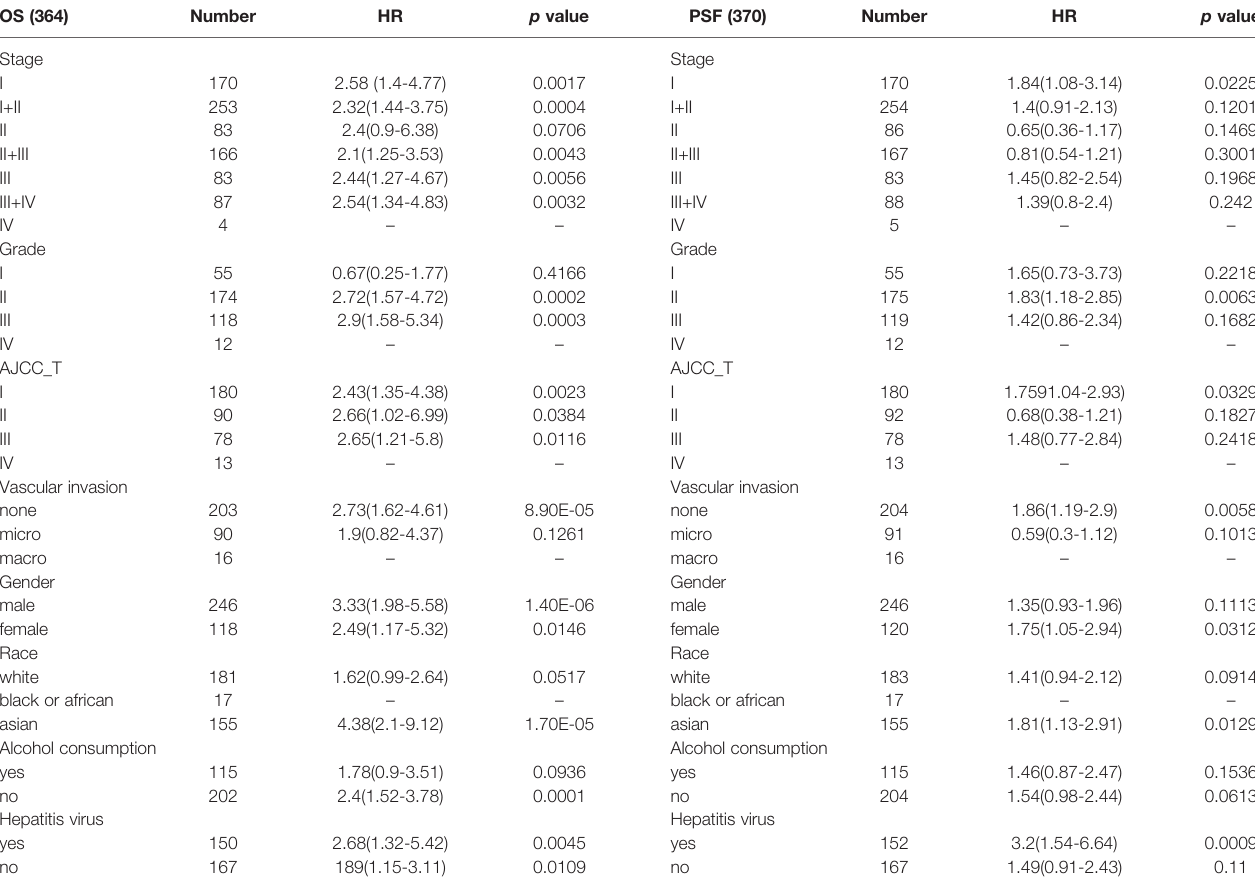
TABLE 1 | Correlation of ATP1B3 mRNA expression with OS ( n = 364) and PFS ( n = 370) in liver hepatocellular carcinoma with different clinicopathological